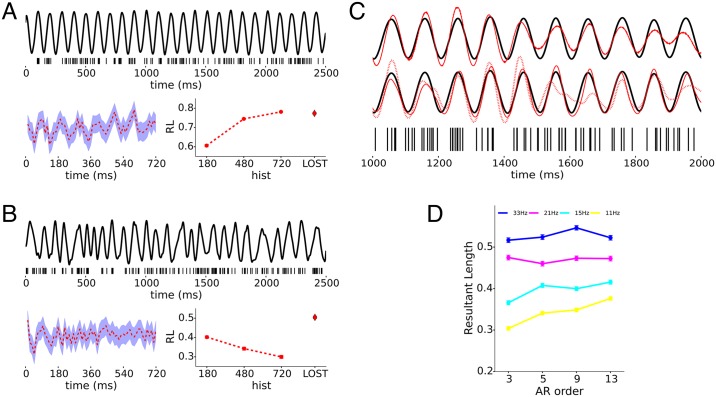
Comparison with other models of spiking and the AR order.Spiking noise and oscillation irregularity affect the quality of phase inference. A, B) Clockwise from top, spike train (ticks) produced by the regular oscillation plotted above, the resultant lengths when oscillation inferred using 3 different history lengths using GLM along with the RL from LOST inference of same data, and the history weights b (dashed red) and their confidence intervals (purple) for GLM using history length 720ms. Modulating oscillations have OCV = 0.02 and 0.2 in A) and B), respectively. C) Sample CIF inference of data shown in A) using LOST (top trace), and GLM (bottom trace), with black line the duplicated ground truth CIFs. For GLM, the dashed (solid) line is the inference obtained from using 720ms (180ms) of spiking history. D) Comparison of how different AR orders for the LOST model affect inference performance for irregular oscillations.